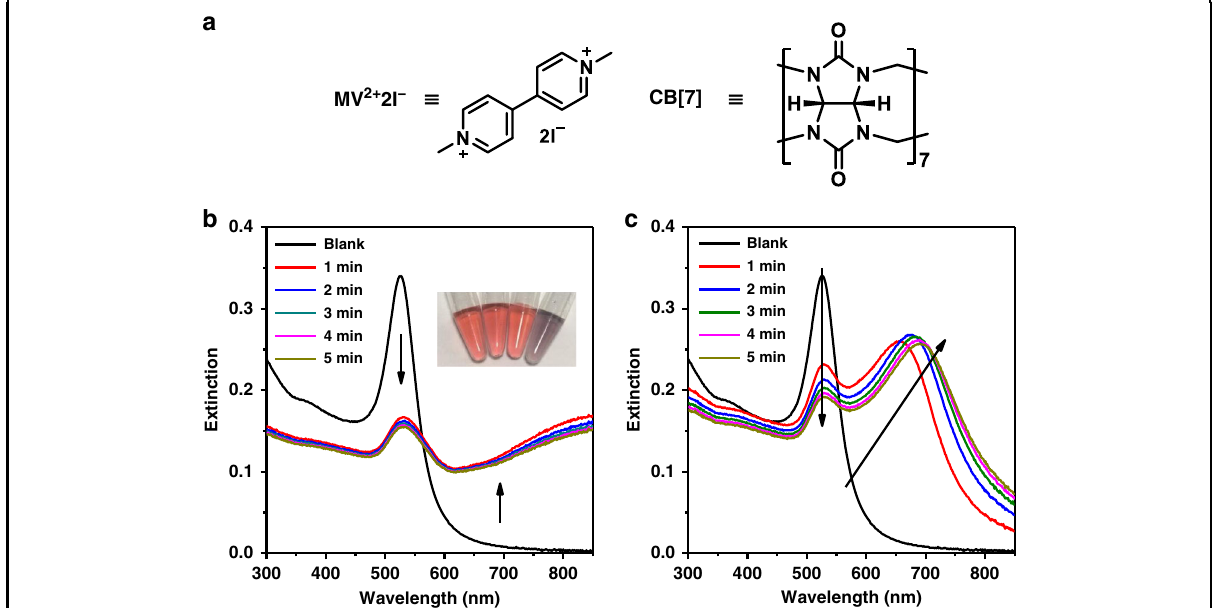
Fig. 1 Host-guest solution induced aggregation of Au NPs. a Molecular structures of MV 2 + 2I − and CB[7]. b Time-dependent extinction spectra of Au NPs colloid obtained by adding MV 2 + 2I − and CB[7]. Inset shows the corresponding photographs of Au NPs colloid (from left to right) on the addition of H 2 O, MV 2 + 2I − , CB[7], and MV 2 + 2I − + CB[7], respectively. The concentrations of MV 2 + 2I − and CB[7] are 2.5 μ M and 0.31 μ M, respectively. c Time-dependent extinction spectra of Au NPs colloid on the addition of 250 μ M